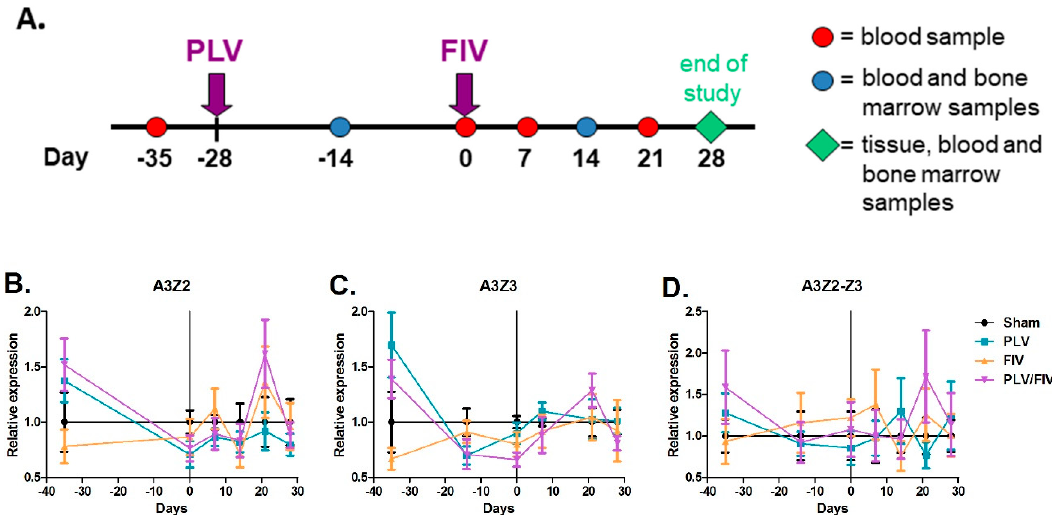
Figure 5. PBMC A3 mRNA expression is not significantly altered following FIV and PLV infection. ( A ) Cats were infected with PLV and four weeks later with FIV (PLV/FIV group, n = 6), with PLV only (PLV group, n = 6), with FIV only (FIV group, n = 6), and sham-infected (Sham, n = 6). PBMCs were isolated from all cats prior to infection (day -35), on the day of FIV infection (day 0), and at weekly intervals until four weeks post FIV infection. A3 expression in PBMCs was determined by qPCR and group means with standard error were plotted relative to the sham-infected group for A3Z2 ( B ), A3Z3 ( C ), and A3Z2-Z3 ( D ). There was no significant difference in A3 expression in bulk PBMC mRNA between the Sham group and any of the lentivirus-infected groups at any time point.